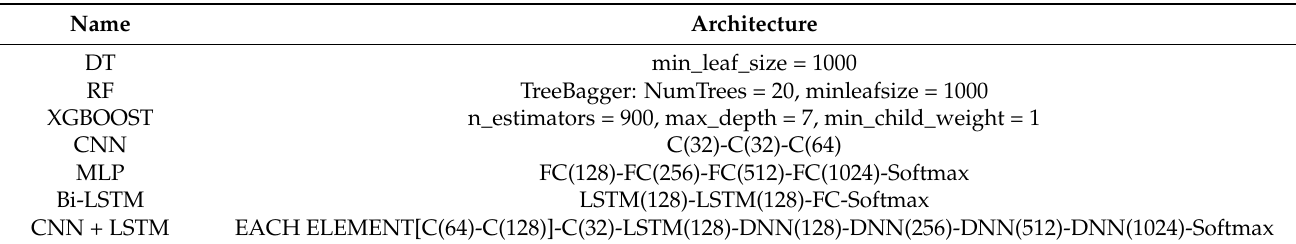
Table 1. The detailed parameters of the baselines.